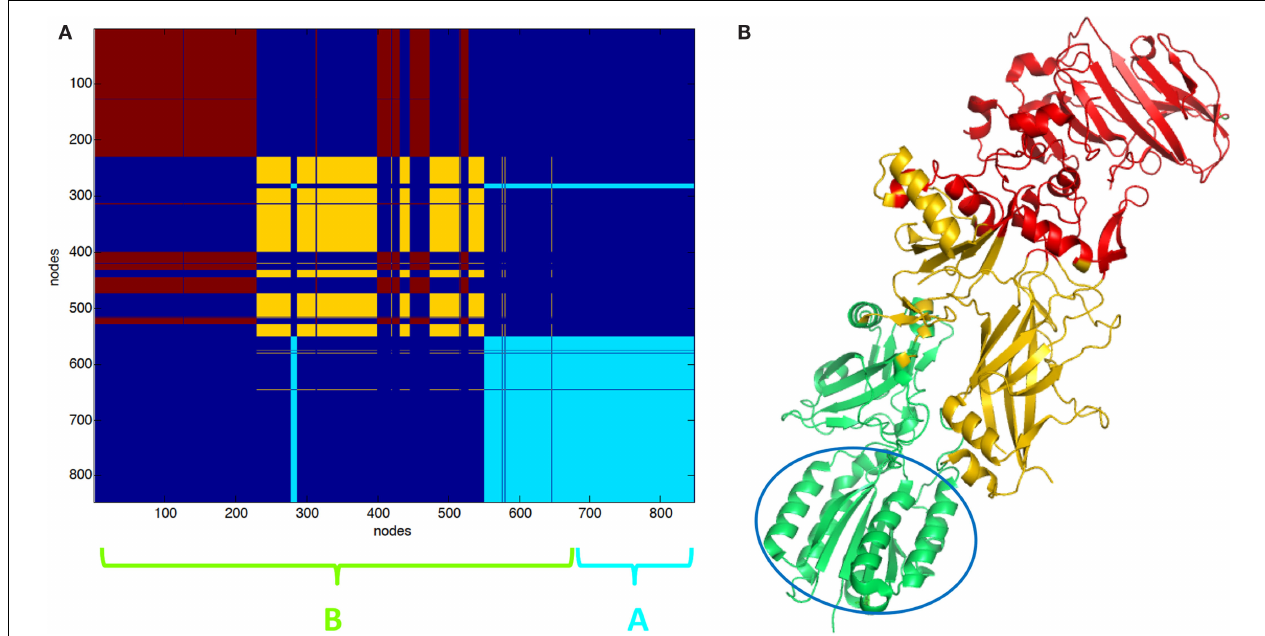
FIGURE 3 | Clustering partition of PA–CMG2 complex: (A) clustering color map, the length of the three chains is reported for reference; (B) cartoon representation of clusters the green cartoon corresponds to the light blue cluster in (A) . The CMG2 receptor is highlighted by the empty circle.